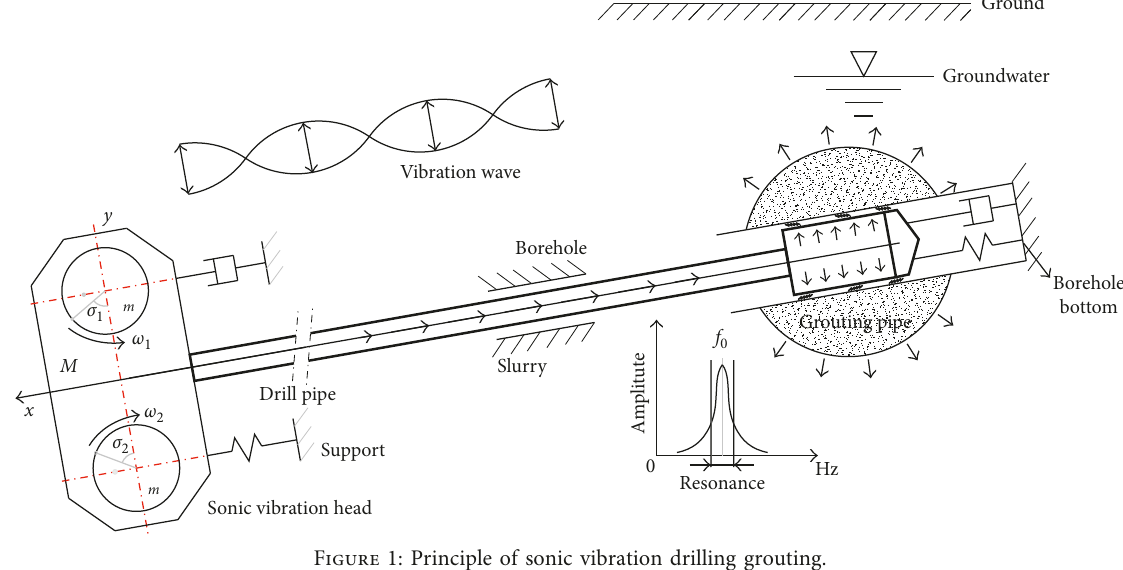
Figure 1: Principle of sonic vibration drilling